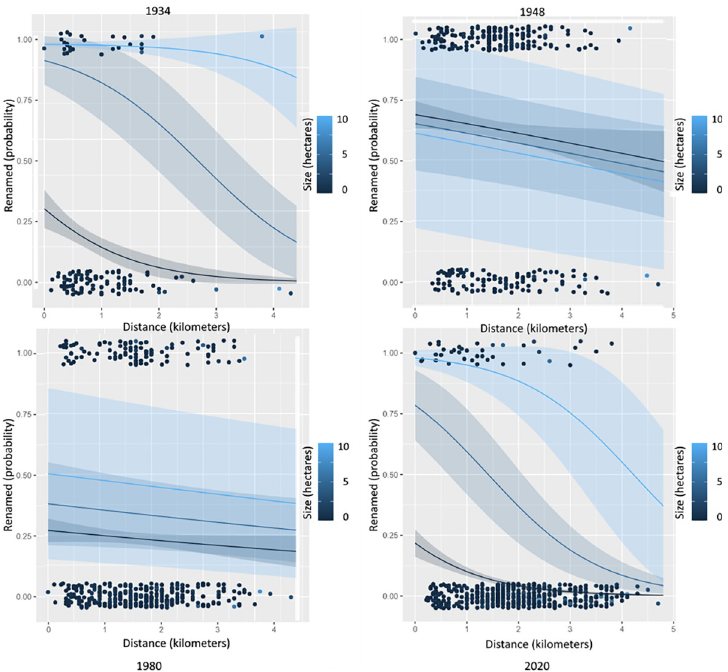
Fig 3. Probability of street renaming by centrality and size in 1934, 1948, 1980, and 2020.